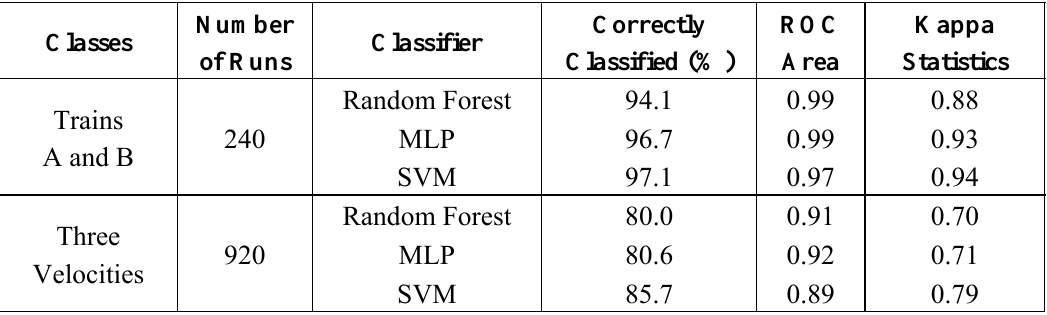
Table 7. Classification results using acoustic